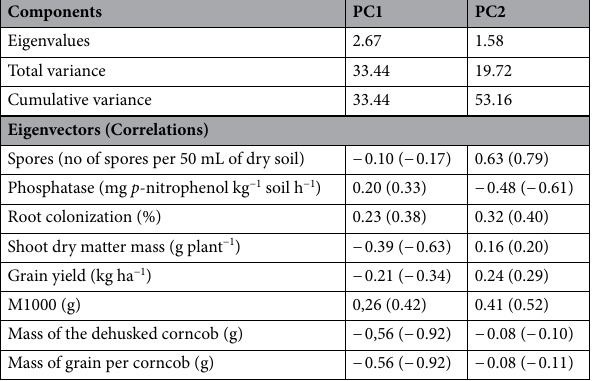
Table 6. Eigenvalues, total and cumulative variance, eigenvectors, correlation coefficients and the two first principal components for the variables related to acid phosphatase, mycorrhizal symbiosis and the yield components in the 2020 crop. PC1 principal component one, PC2 principal component two.